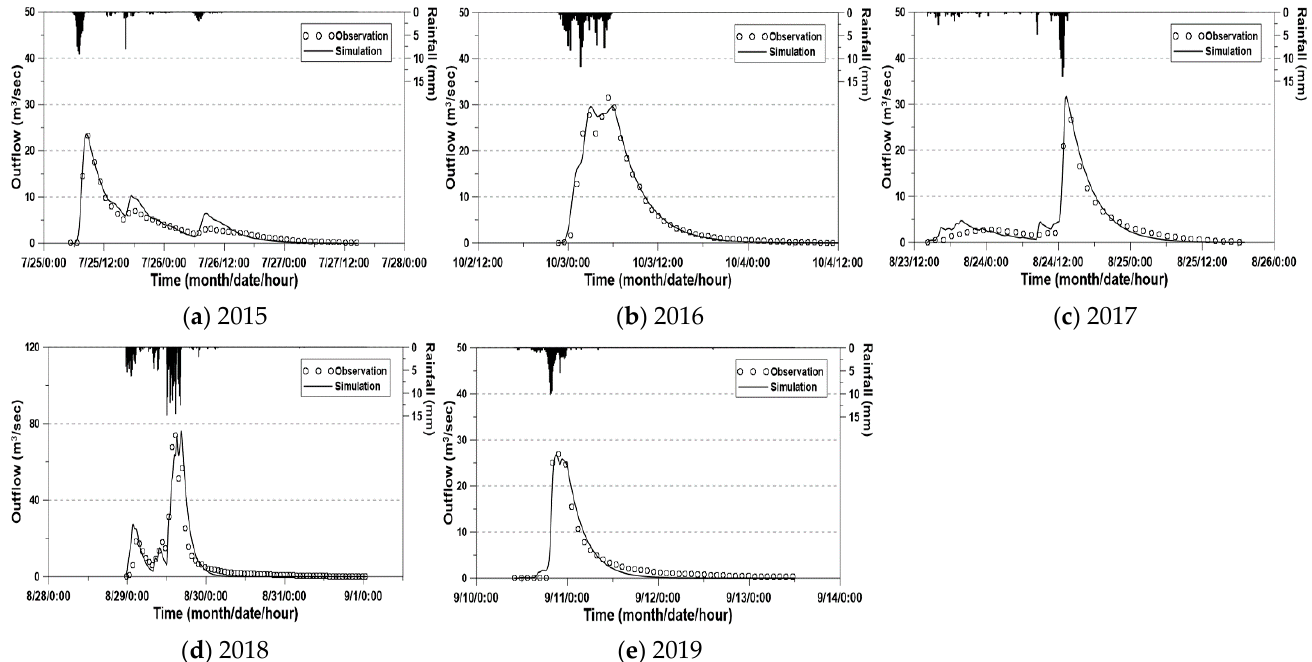
Figure 6. Comparison of the observed and simulated runoff hydrographs derived based on analytically-derived Clark IUH with different channel and hillslope velocity for the events occurred in 2015 ( a ); 2016 ( b ); 2017 ( c ); 2018 ( d ); and 2019 ( e ).